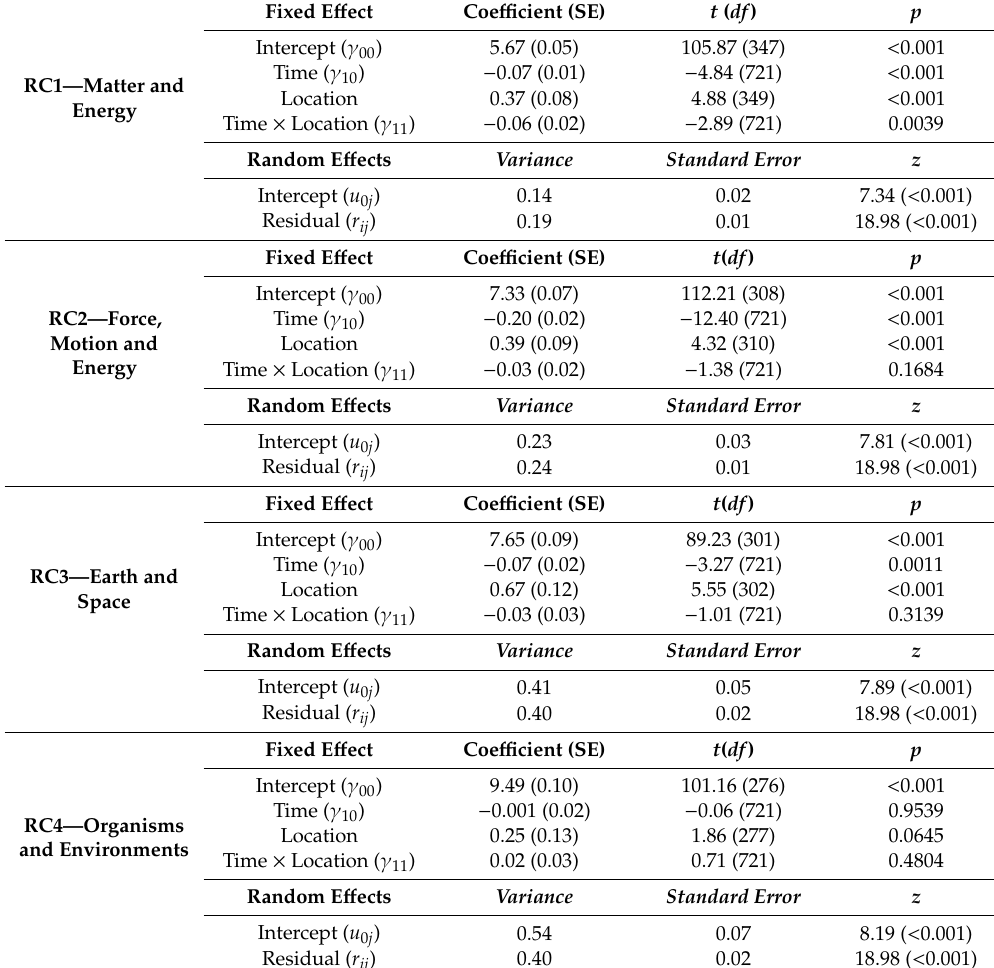
Table 6. Parameter estimates of fixed and random e ff ects of Model 4 by reporting